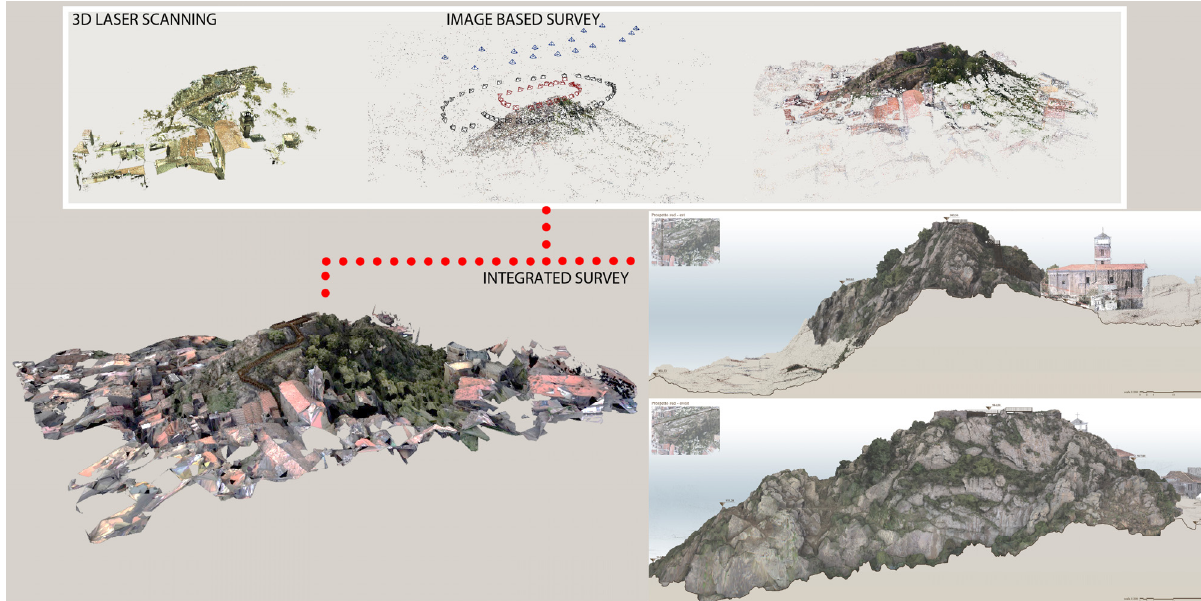
Figure 2 . Maletto Castle. Integrated survey of the